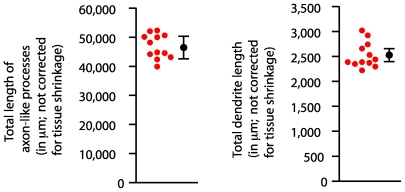
Quantification of axon-like processes and dendrite lengths for type 1 DA cells.Red circles, lengths calculated from the Neuromantic tracing of BBBA clarified retinas. BBBA causes ∼30% tissue shrinkage. Black circle and error bars, mean+/−S.D.